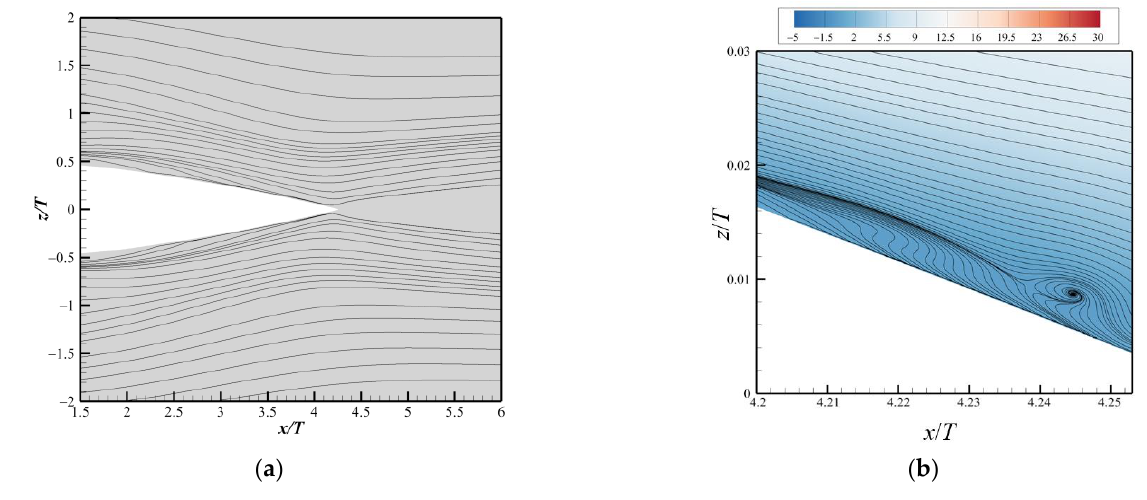
Figure 7. Streamlines on bottom wall calculated using SLA-IDDES: ( a ) streamlines with a fishtail shape at trailing edge; ( b ) flow separation at the trailing edge, colored by the streamwise velocity.